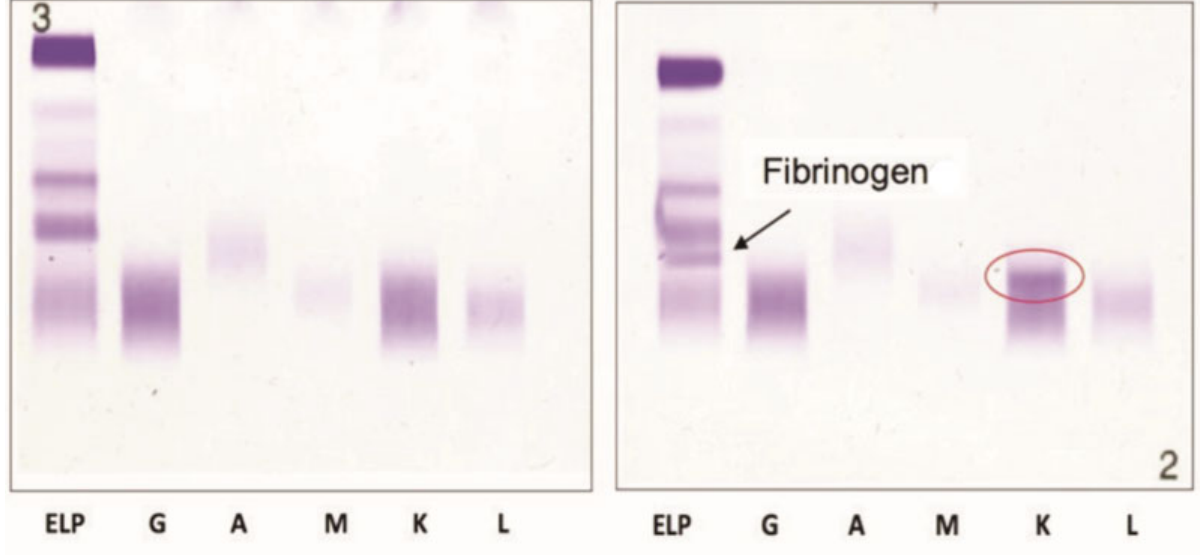
Fig. 1 Protein serum immuno fi xation (on the left) and plasma protein immuno fi xation (on the right). The circle underlines k monoclonal light